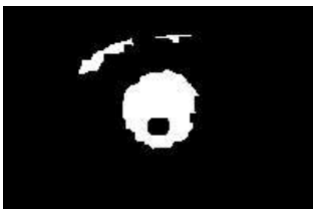
Figure 4. Detection of the infrared reflection in the pupil.